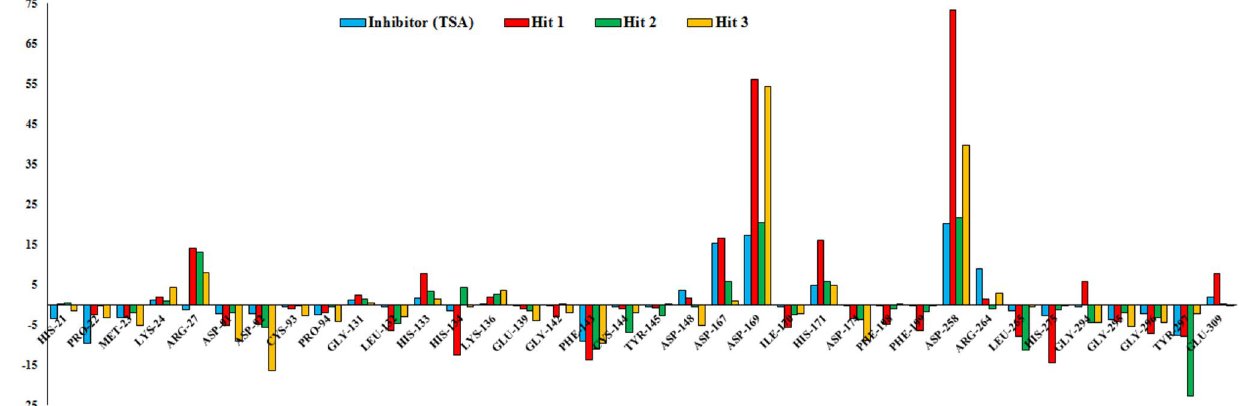
Figure 12. Energetic contribution of individual residues from simulated protein–ligand complexes of Inhibitor (TSA, Blue color), Hit 1 (Red color), Hit 2 (Green color) and Hit 3 (Yellow color) with HDAC3. The figure is drawn using Microsoft Excel 2013